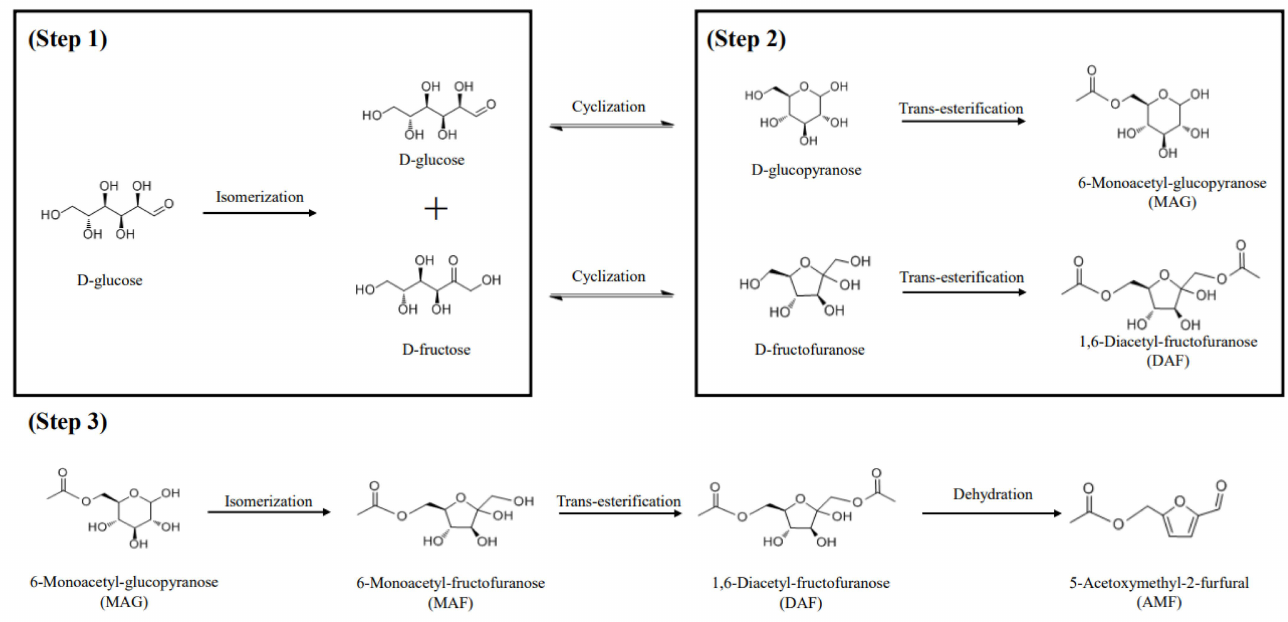
Figure 1. The synthesis route of 1,6-diacetylfructose (DAF). ( Step 1 ) Isomerization of glucose to fructose. ( Step 2 ) Hybrid esterification of the fructose and glucose mixture. ( Step 3 ) Re-isomerization of 6-Monoacetyl-glucopyranose (MAG) and re-esterification of 6-Monoacetyl-fructofuranose